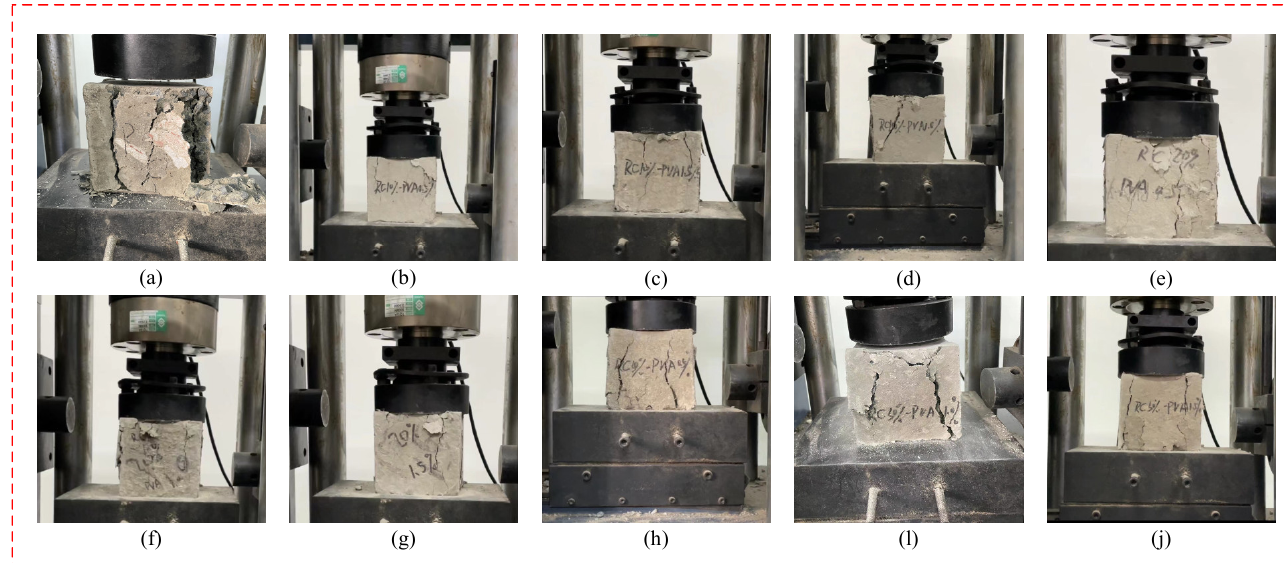
Figure 6. Compression failure morphology of PVA rubber/concrete specimens with different contents: ( a ) PC; ( b ) RC10%-PVA0.5%; ( c ) RC10%-PVA1.0%; ( d ) RC10%-PVA1.5%; ( e ) RC20%-PVA0.5%; ( f ) RC20%-PVA1.0%; ( g ) RC20%-PVA1.5%; ( h ) RC30%-PVA0.5%; ( i ) RC30%-PVA1.0%; ( j ) RC30%-PVA1.5%.